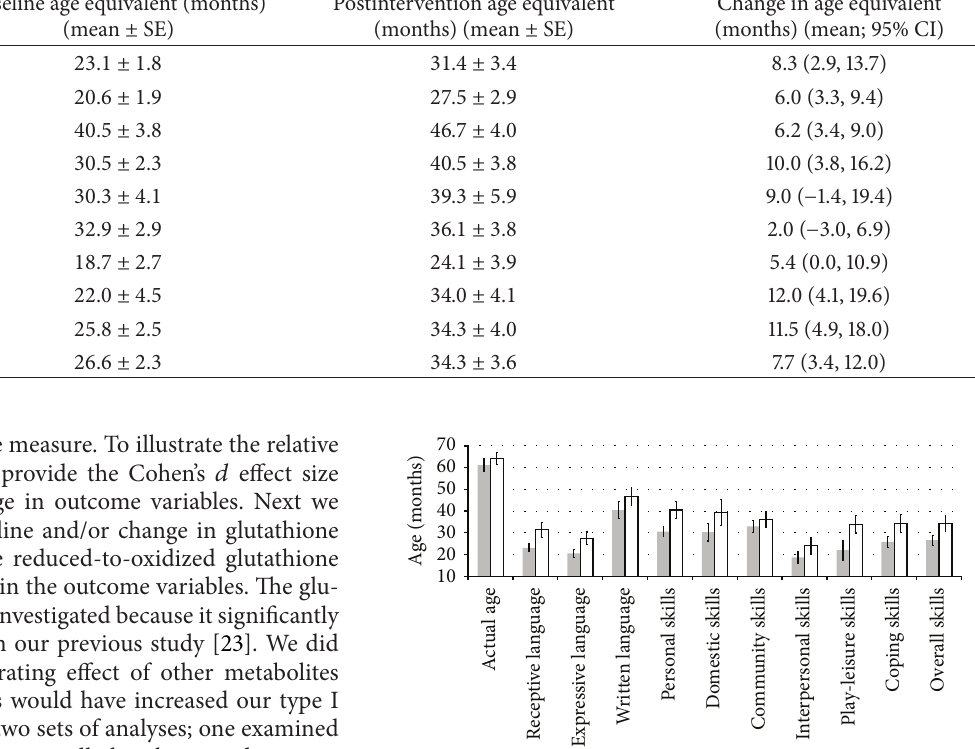
Figure 2: Histogram of actual age and age equivalents for the Vineland Adaptive Behavior Scale subscales. Error bars depict standard